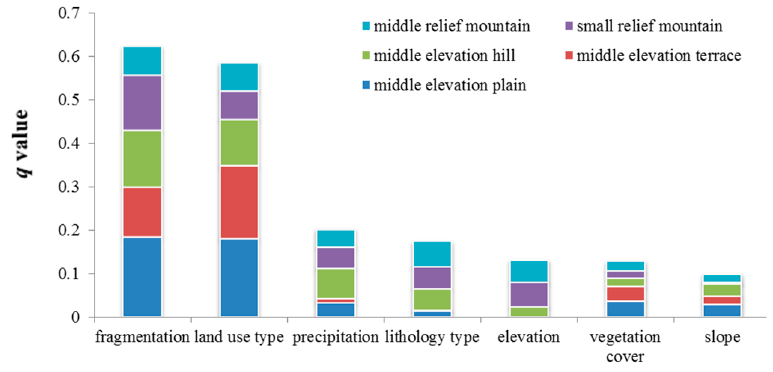
Figure 4. The q values of the factors influencing the groundwater in the di ff erent geomorphic regions.